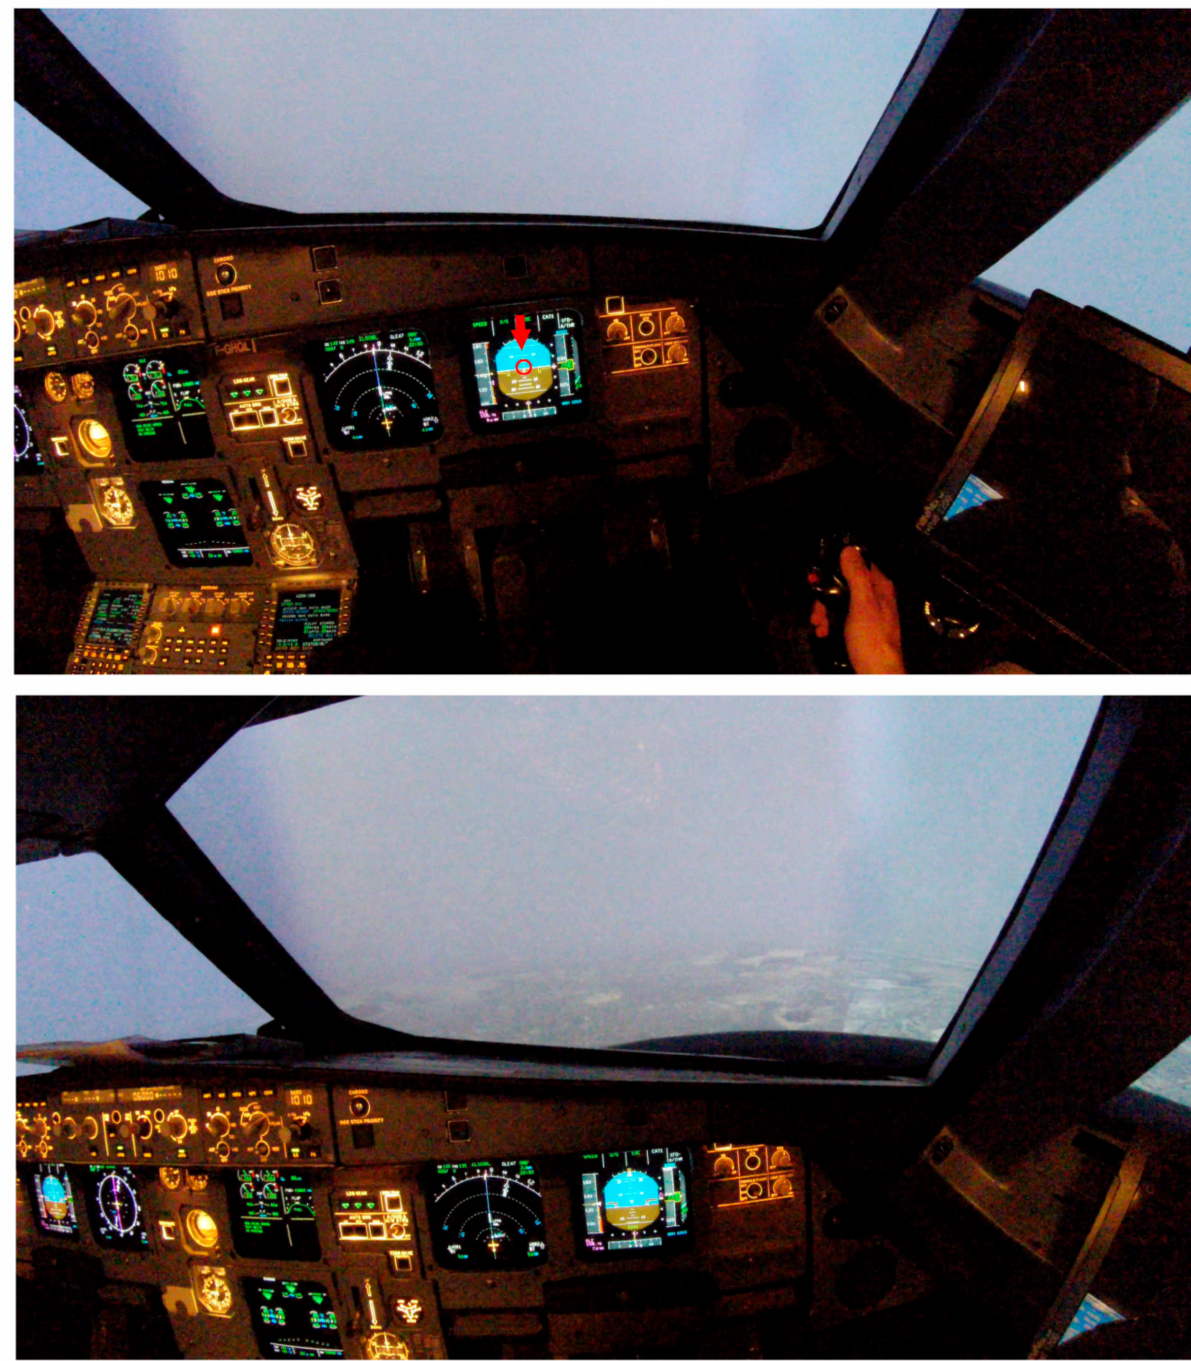
Figure 4. Top picture : Illustration of a first-person point-of-view eye-tracking video recording, showing eye fixations during the approach (the red circle indicated by an arrow in the center of the attitude indicator) from one of the most accurate pilots (administered to the experimental group). Bottom picture : Illustration of the first-person point-of-view video during approach (recorded with a head-mounted GoPro camera) without any indication of eye fixation (administered to the control